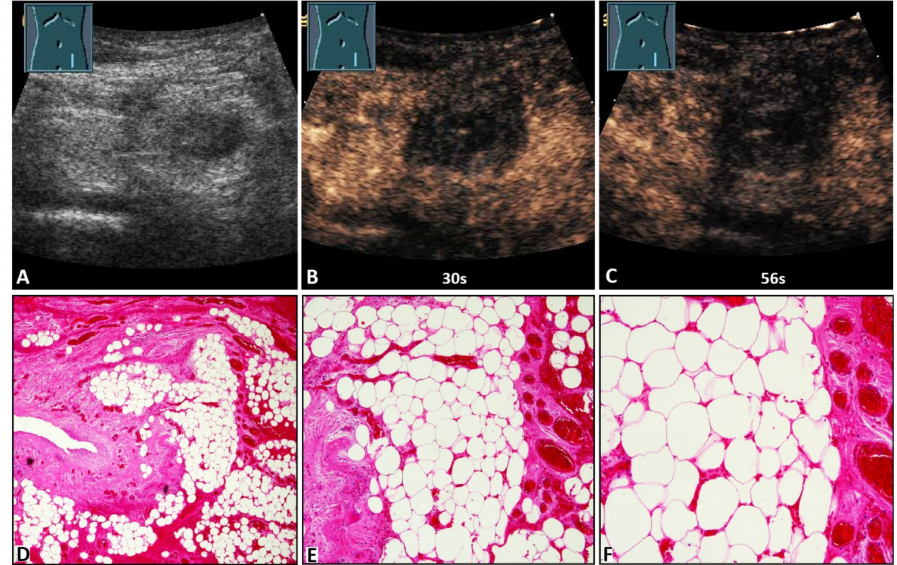
Figure 3. A 47-year-old female patient with acute peritoneal pain in the left lower abdomen and a palpable inguinal-located tumor. ( A ) B-mode ultrasound shows a hyperechoic lesion with a central hypoechoic area. ( B , C ) On contrast-enhanced ultrasound, the lesion shows absent enhancement after 30 s and 56 s, and an omental hernia was diagnosed. ( D ) Omentum with partial fibrotic consolidation (on the left) and dilated hyperemic capillaries and hemorrhages (4 × magnification). ( E ) Omentum with central necrotic fat tissue (missing nuclei), fibrosis (to the left), and dilated hyperemic capillaries and hemorrhages (on the right) (10 × magnification). ( F ) Omentum with central necrotic fat tissue, and dilated hyperemic capillaries and hemorrhages (20 × magnification).